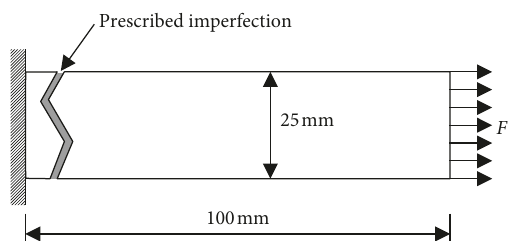
Figure 11: A bar subjected to uniaxial tension.